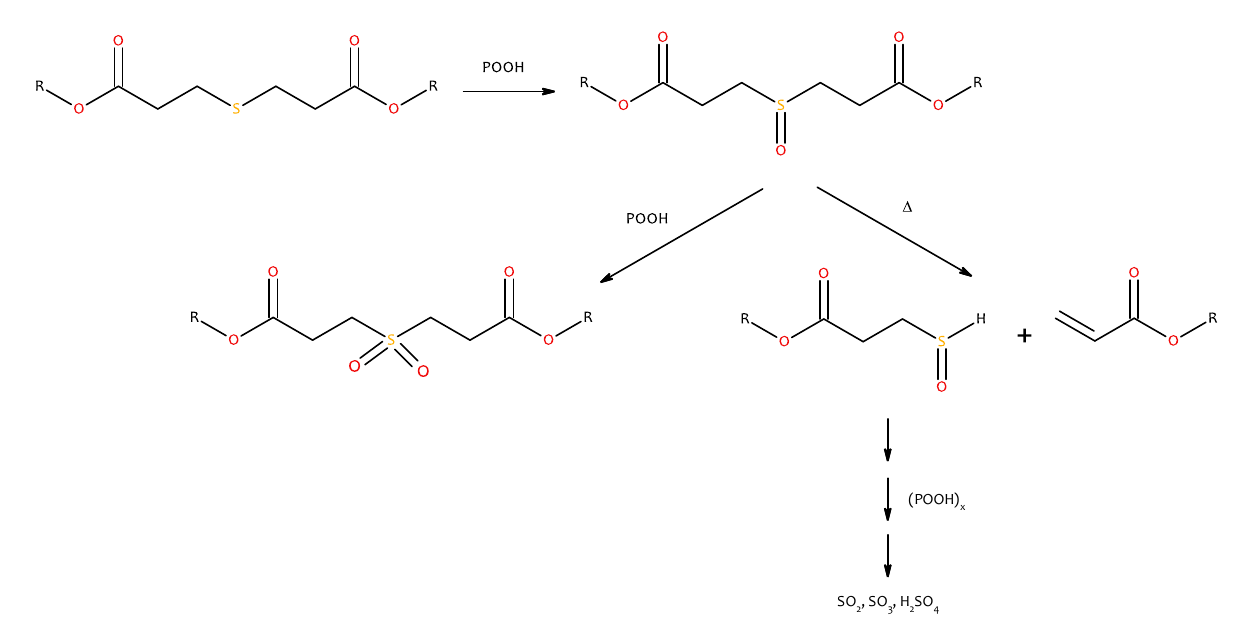
Figure 6. Schematic reactional mechanism of thioesters action, redrawn from Figure 1 of the article of Richaud et al. [46].